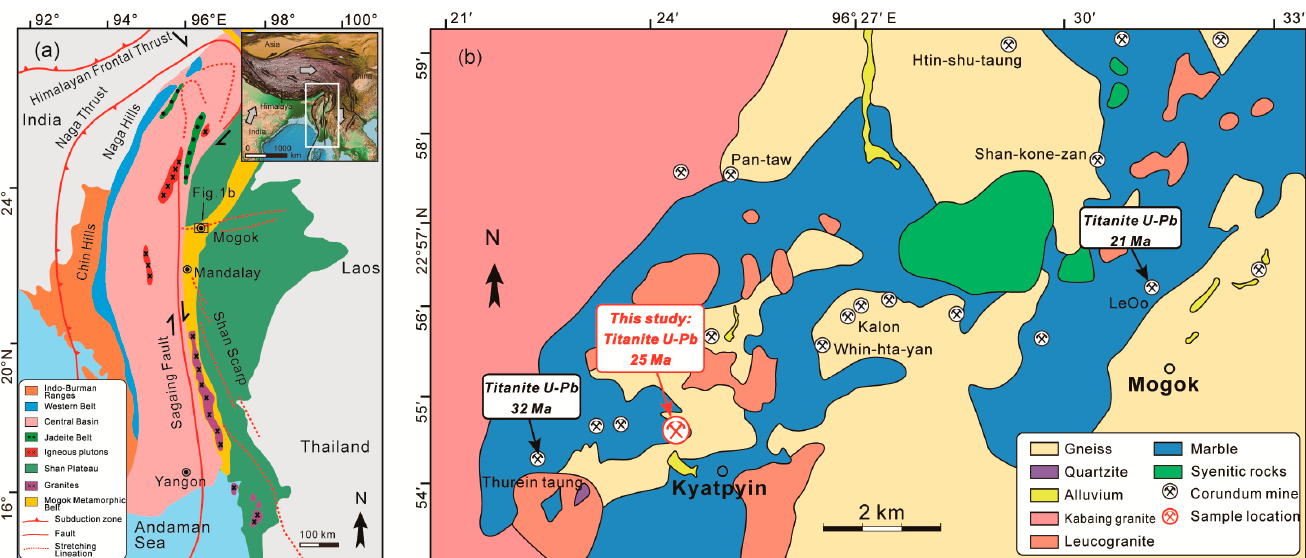
Figure 1. ( a ) Geological sketch map of Myanmar, modified after Guo et al. [30]. ( b ) A simplified geological map of the Mogok region (modified from Zaw et al. [43]) showing the distribution of various lithologies and the location of the studied samples.